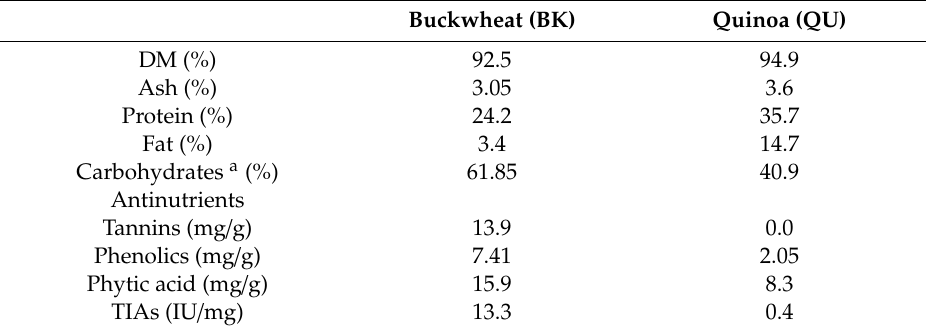
Table 2. Chemical composition of buckwheat and quinoa protein-rich